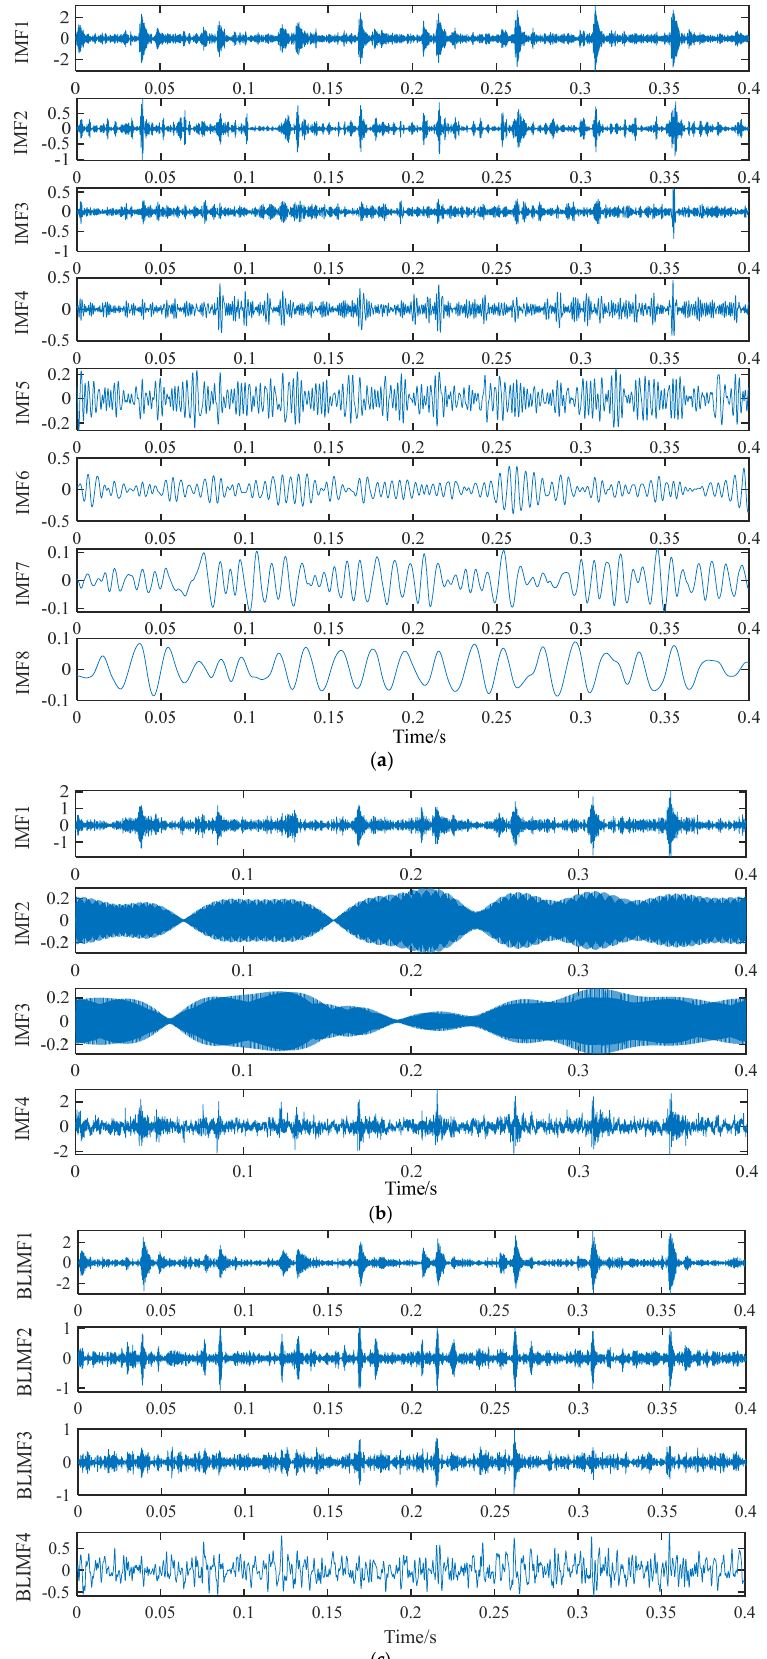
guished from the spectrum. The spectrum division of the EWT method is shown in Figure 7b, and the second and third boundaries are concentrated in the middle, almost overlap- ping and indistinguishable from the spectrum. In Figure 7c, the optimized VMD was de- composed into four BLIMFs components, the frequency range of BLIMF4 is 0–658 Hz, and the fault frequency is mainly in this region, indicating that the optimized VMD has a good effect.